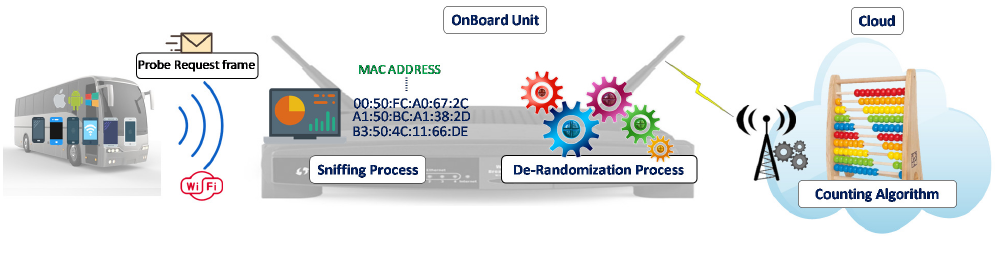
Figure 1. iABACUS.